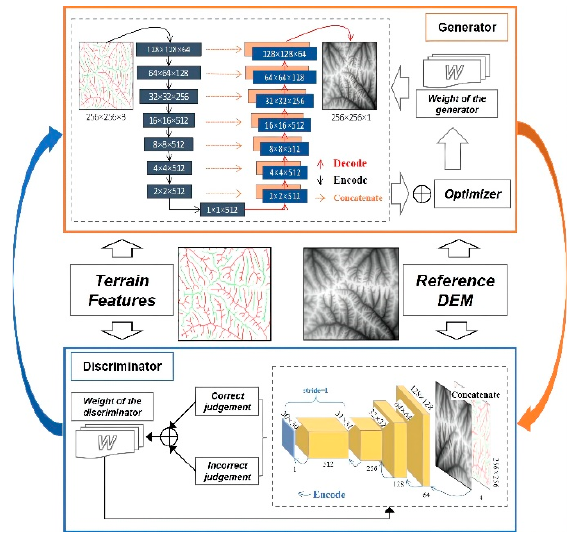
Figure 3. The structure of Terrain-CGAN.